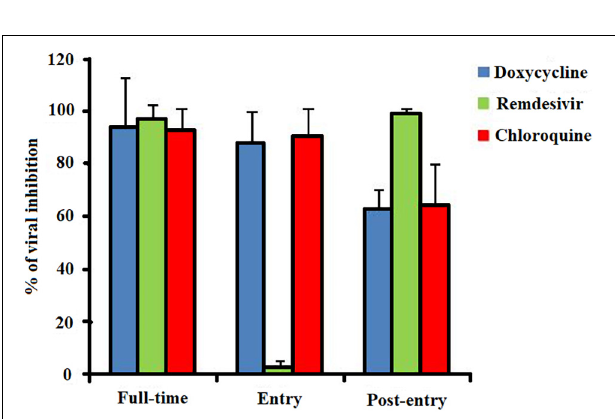
FIGURE 6 | In vitro antiviral activity of doxycycline, chloroquine, and remdesivir at 10 µ M against the SARS-CoV-2 IHUMI-3 strain. For the “full-time” treatment, Vero E6 cells were infected with the IHUMI-3 strain for 48 h after pre-incubation of the cells with one of the three drugs for 4 h. For the “entry” treatment, the cells were infected for 2 h after pre-incubation for 4 h and then the virus-drug mixture was replaced with fresh medium maintained for 46 h. For the “post-entry” treatment, the cells were infected for 2 h and then incubated with drug for 46